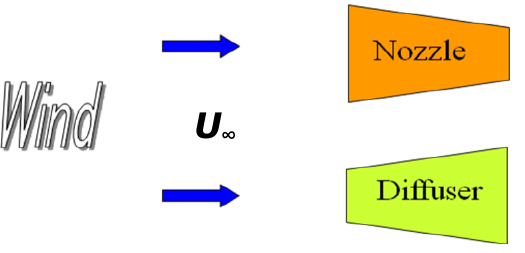
Figure 1. Two types of hollow